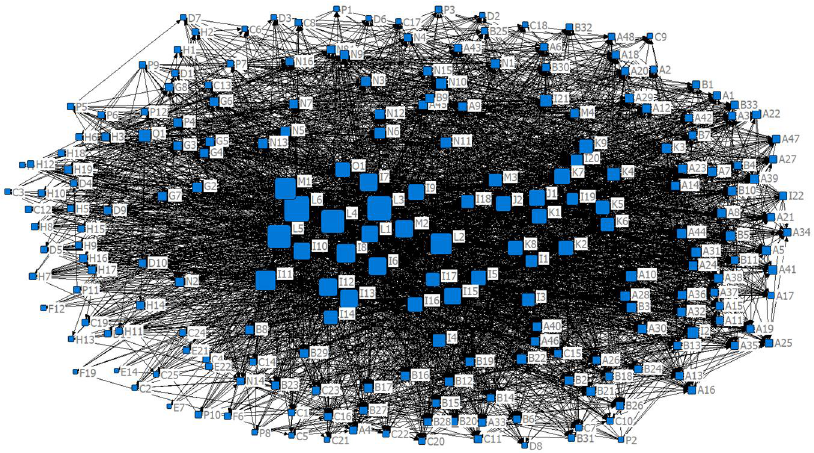
Figure 5. Inter-actor innovation network of ecological agriculture.